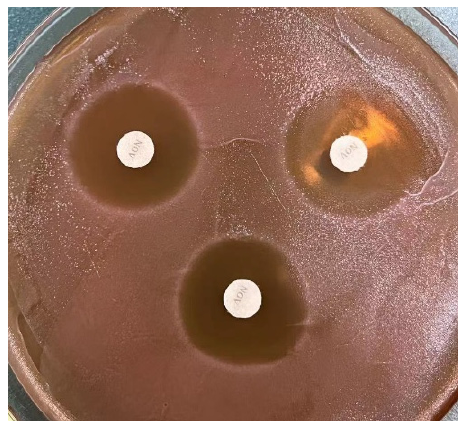
Figure 5. Sensitivity of M5 to novobiocin (NOV). Table 8. Drug sensitivity test results.